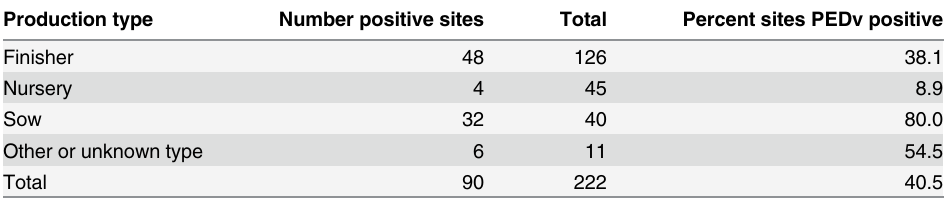
Table 2. Porcine epidemic diarrhea virus (PEDv) site-level status during a Spring 2013 outbreak in 4 contiguous U.S. States, by production